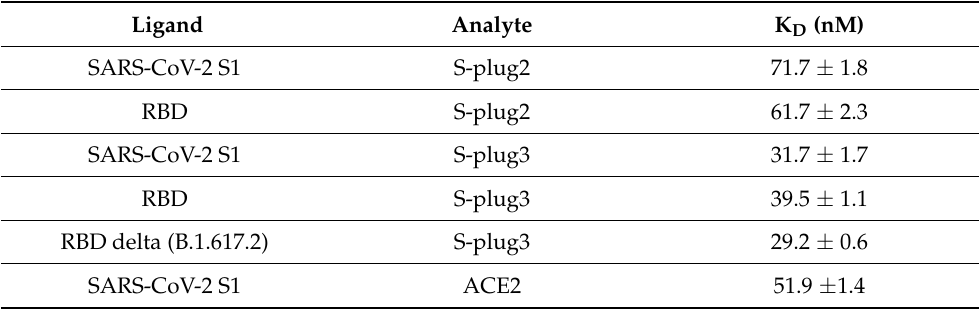
Table 2. Binding parameters of SARS-CoV-2 spike to S-plugs and ACE2 receptor. Dissociation constants were measured by